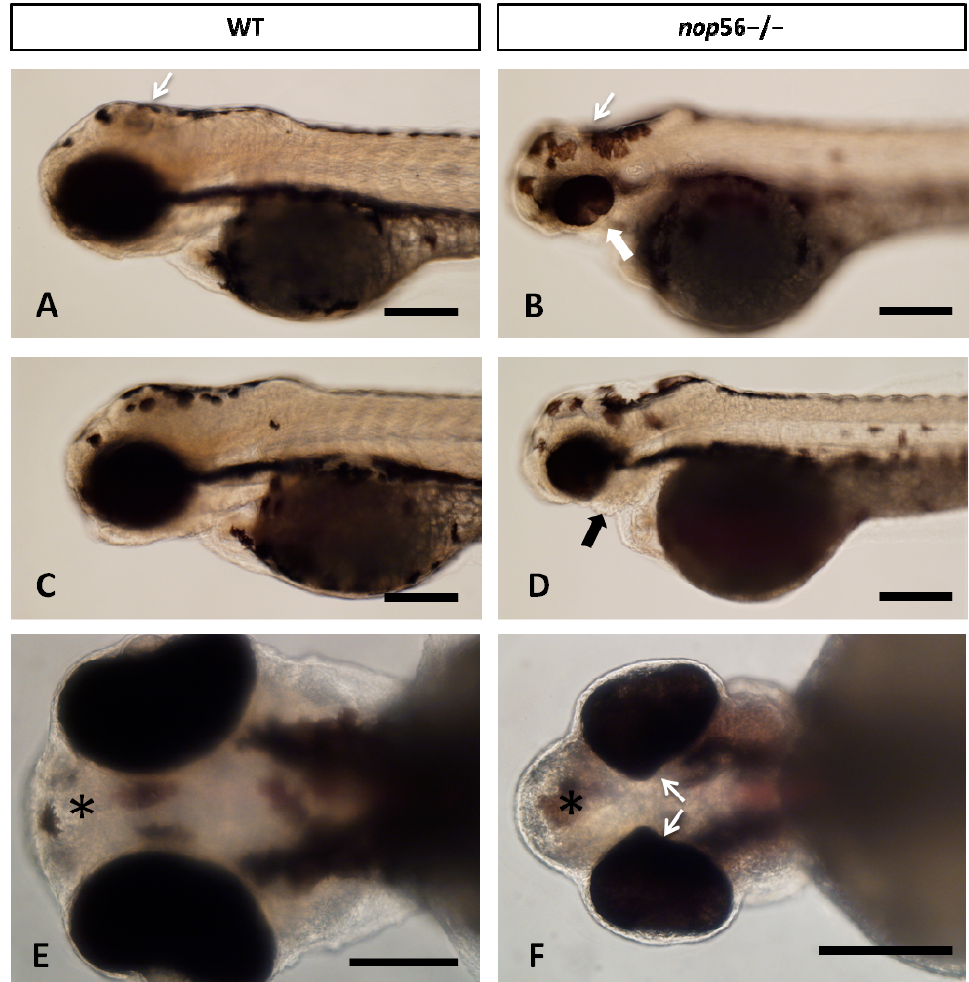
Figure 2. ( A – D ) Lateral views of WT and nop56 − / − larvae (3.5 dpf), showing coloboma (white thick arrow in ( B )) and jaw malformation (black arrow in ( D )) in the homozygous fish. Note also differences in the midbrain and cerebellum (thin white arrows). ( E , F ) Ventral view of WT and nop56 − / − fish showing malformation of the eye (arrows) and forebrain (asterisk). Scale bar: 125 μ m.